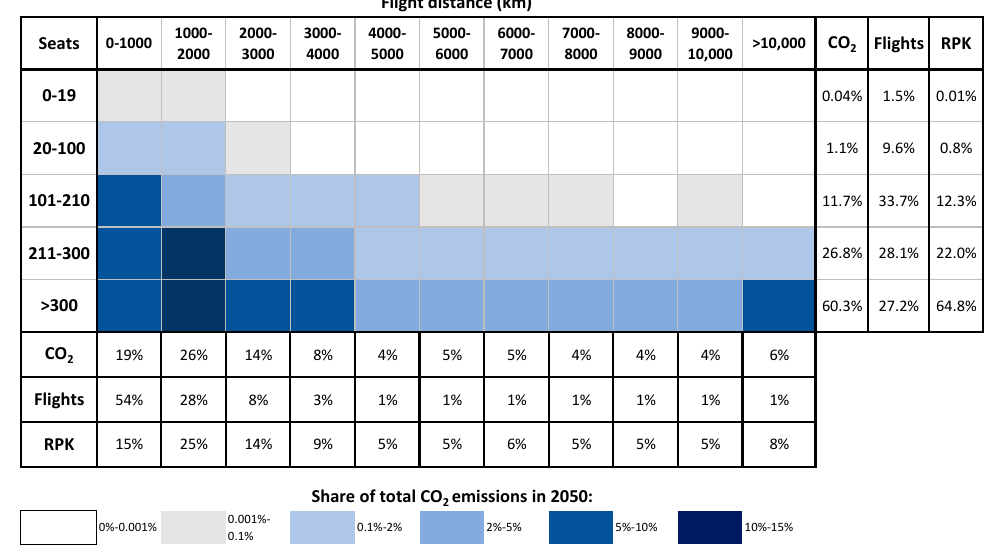
Figure 21 . Distribution of CO 2 emissions by seat class and flight distance in 2050.